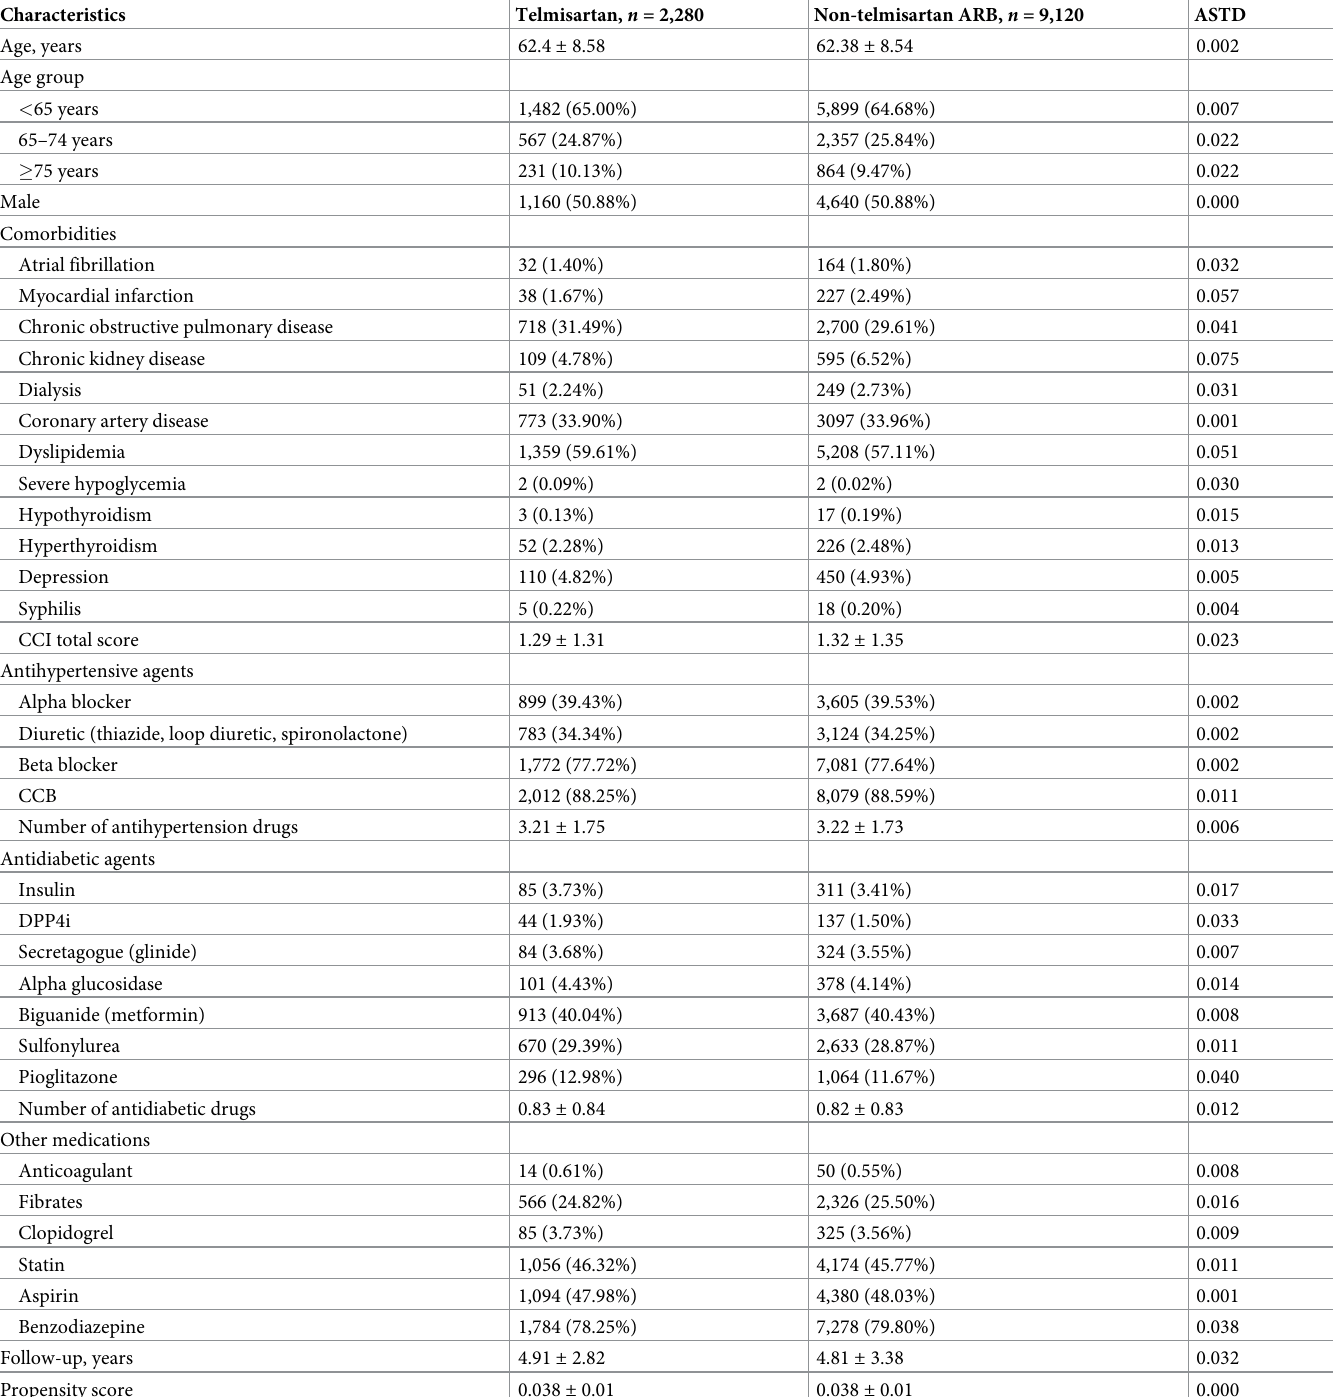
Table 1. Characteristics of the study patients with and without use of telmisartan after propensity score matching.